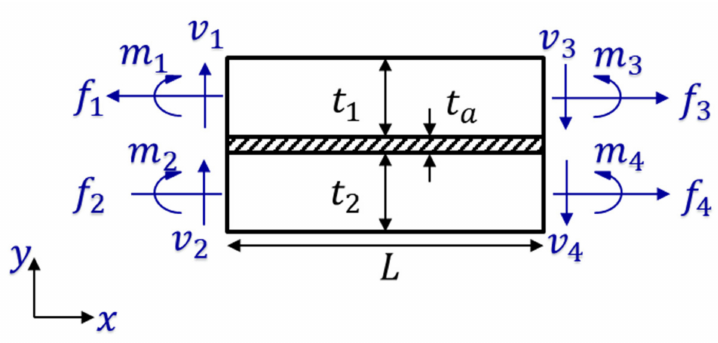
Figure 2. A sandwich model representation of the bonded